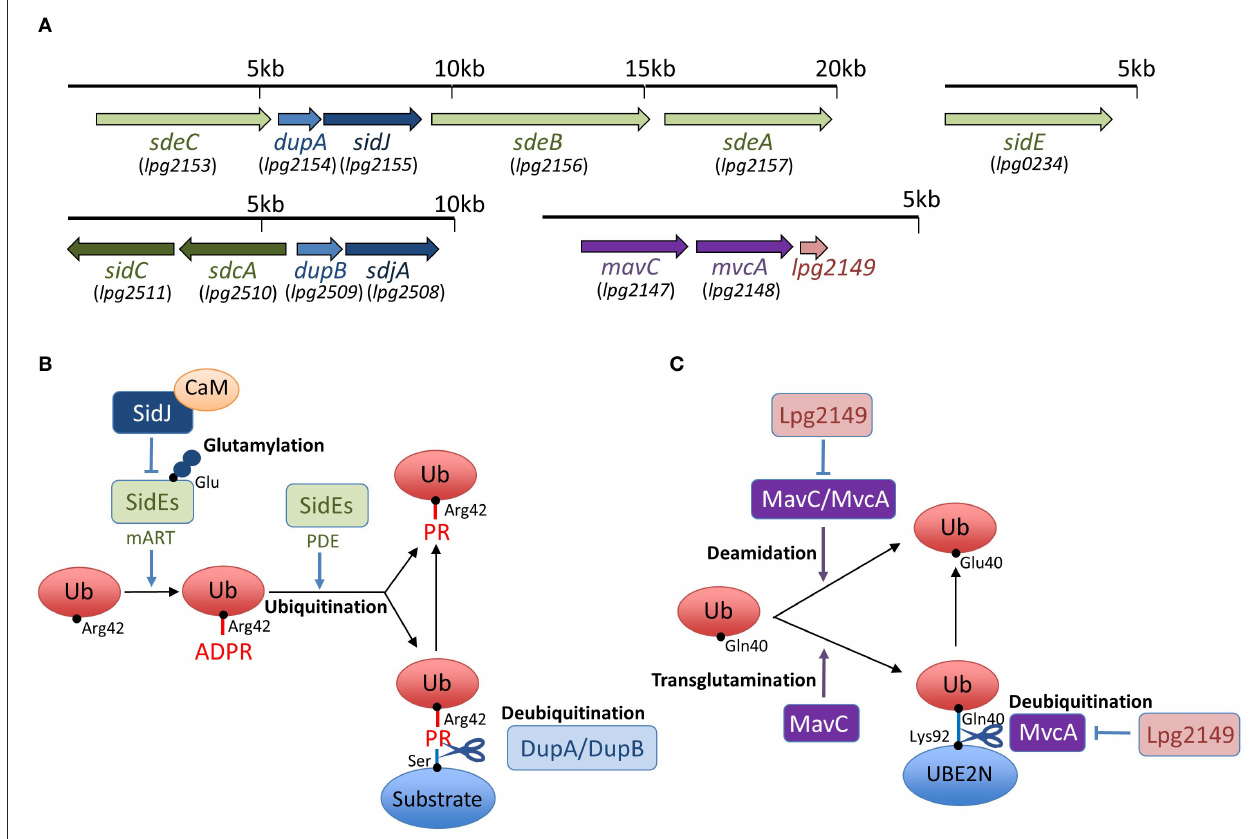
FIGURE 1 | Schemes of effector interplay in the regulation of unconventional ubiquitination and gene organization of sidEs , dupA/dupB , sidJ/sdjA , and mavC/mvcA loci in L . pneumophila . (A) SidEs are encoded in two loci in the L . pneumophila genome. sdeA , sdeB , and sdeC genes are in a cluster, and the sidE gene is in a separate locus. DupA is encoded in the same locus as sdeA , sdeB , and sdeC , while DupB is encoded in a different locus. SidJ is encoded in a locus with sdeA , sdeB , sdeC , and dupA . sdjA is thought to be a paralogue of sidJ , representing in the same locus with dupB . mavC and mvcA are tandem-arrayed paralogous genes adjacent to lpg2149 . (B) SidEs have an equivalent function in PR-ubiquitination mediated by mART and PDE activities. Products of the paralogous genes dupA and dupB can reverse PR-ubiquitination with their unique deubiquitination activity. Together with the cofactor CaM, SidJ executes an enzymatic effect to glutamylate the active site of the mART domain of SidEs, thereby inhibiting SidEs-mediated ubiquitination (see text for details). (C) MavC and MvcA display deamidation activity against ubiquitin. MavC, but not MvcA, possesses a transglutamination activity and forms a covalent bond between ubiquitin and the E2 enzyme UBE2N. The unconventional ubiquitination of UBE2N can be reversed by the unique DUB activity of MvcA. Lpg2149 can prevent the deamidase activity of both MavC and MvcA. It can also prevent the DUB activity of MvcA (see text for